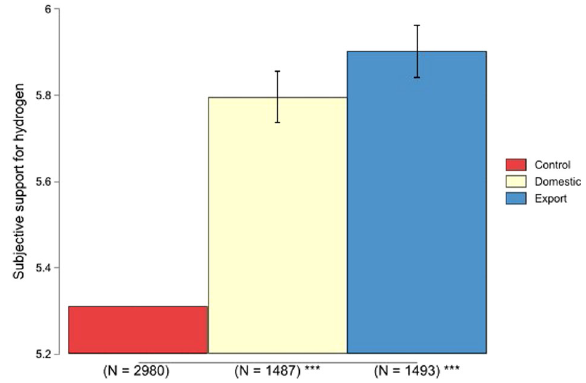
Fig. 3 Effect of SV on the subjective outcome before and after the treatment using the Stream dummies as treatment variables. The result is reported in Table S4 (Model 3). The graph is based on Bjarkefur et al. (2022).